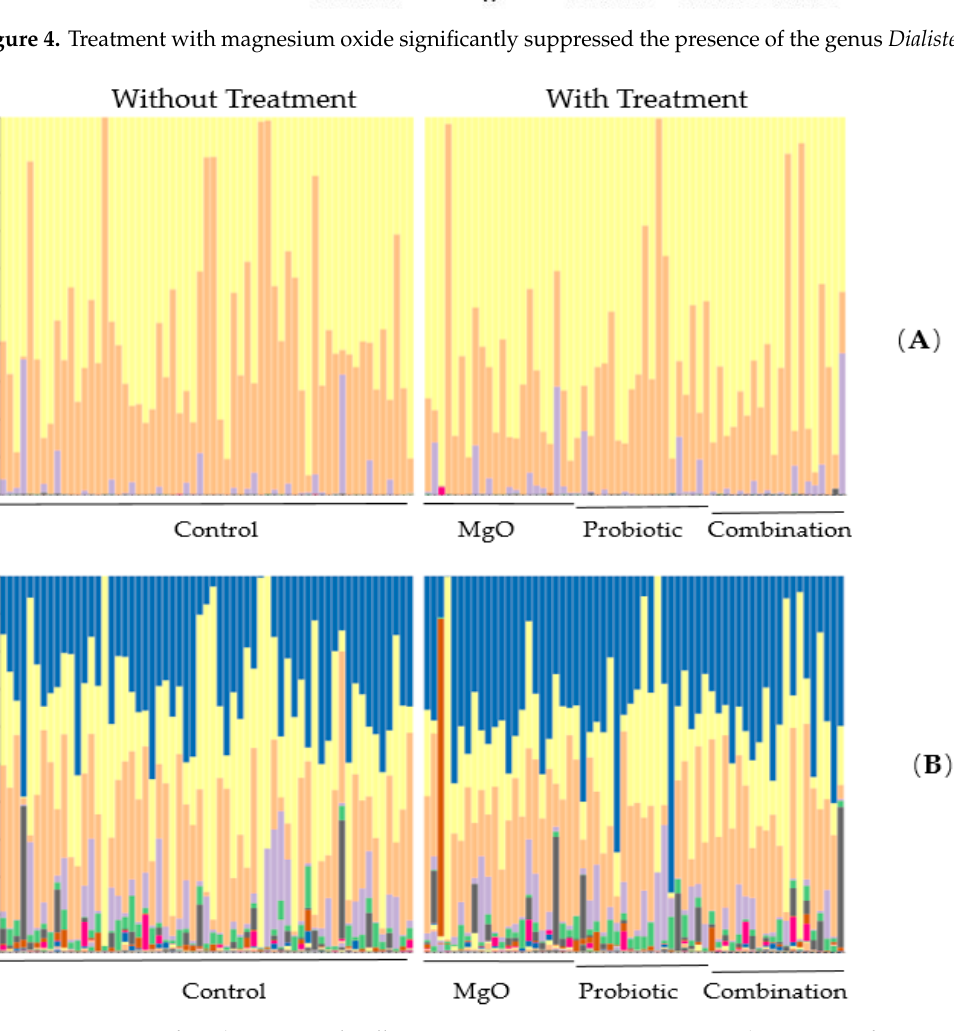
Figure 5. Impact of probiotic Lactobacillus reuteri DSM 17938 on gut microbiome in infants with functional chronic constipation. The relative abundance of the gut microbiome was plotted in taxa bars based on the phylum level ( A ) and genus level ( B ).